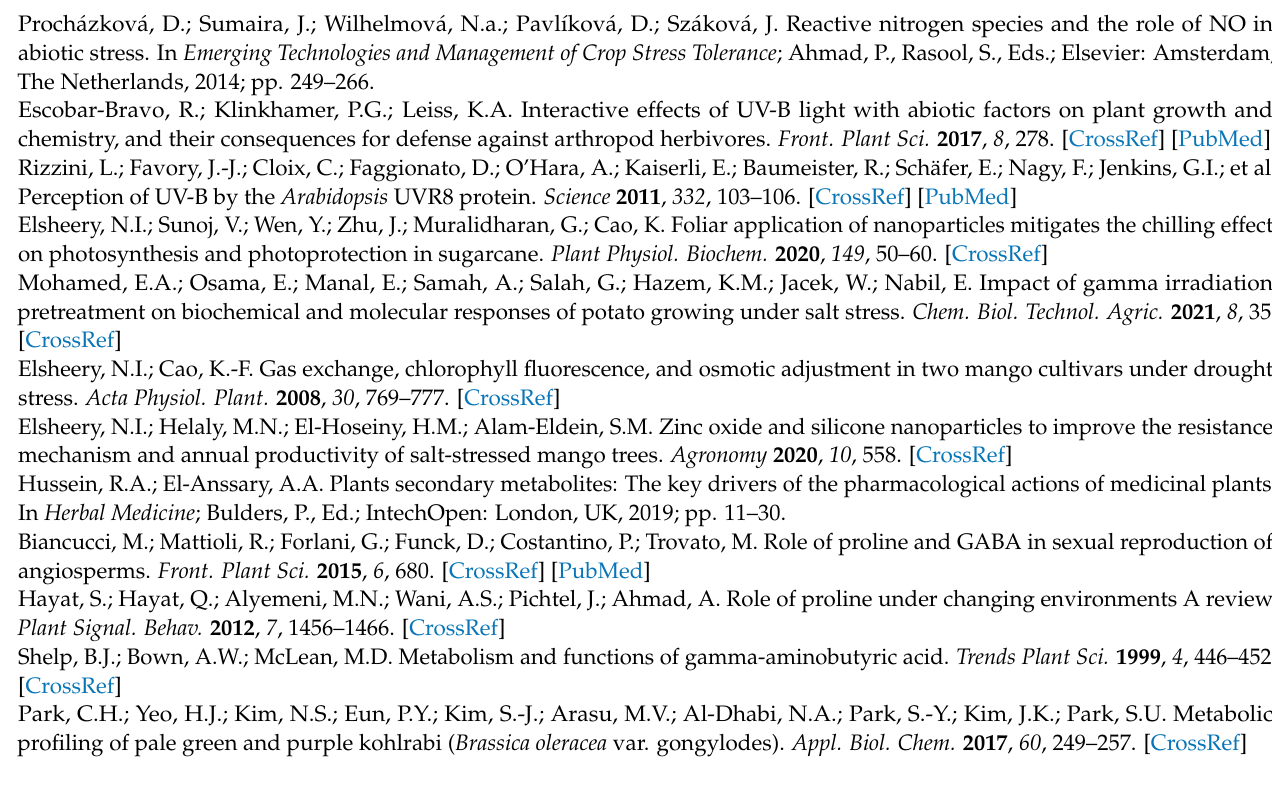
Figure S3. GC-TOFMS chromatogram of hydrophilic compounds in UVB-treated purple kohlrabi sprouts. Peak: 1, Pyruvic acid; 2, Lactic Acid; 3, Alanine; 4, Oxalic acid; 5, Glycolic acid; 6, Valine; 7, Urea; 8, Serine-1; 9, Ethanolamine; 10, Phosphoric acid; 11, Glycerol; 12, Leucine; 13, Isoleucine; 14, Proline; 15, Glycine; 16, Succinic Acid; 17, Glyceric Acid; 18, Fumaric Acid; 19, Serine-2; 20, Threonine; 21, β -Alanine; 22, Malic acid; 23, Aspartic Acid; 24, Methionine; 25, Pyroglutamic Acid; 26, 4-Aminobutyric Acid; 27, Threonic acid; 28, Cysteine; 29, Glutamic Acid; 30, Phenylalanine; 31, Xylose-1; 32, Xylose-2; 33, Arabinose; 34, Asparagine; 35, Xylitol; 36, Ribitol (internal standard) 37, Putrescine; 38, Glutamine; 39, Shikimic acid; 40, Citric acid; 41, Quinic acid; 42, Fructose-1; 43, Fructose-2; 44, Mannose; 45, Glucose-1; 46, Glucose-2; 47, Mannitol; 48, Lysine; 49,Tyrosine; 50, Inositol; 51, Ferulic acid; 52, Tryptophan; 53, Sinapinic acid; 54, Fructose-6-phosphate; 55, Glucose-6- phosphate-1; 56, Glucose-6-phosphate-2; 57, Sucrose; Figure S4. Correlation matrix of anthocyanins, ABTS values, and total phenolics (TPC) in UVB-irradiated purple kohlrabi sprouts. Control, purple kohlrabi sprouts grown without UVB irradiation for 0 h, 6 h, 12 h, 24 h, and 48 h; test, purple kohlrabi sprouts irradiated with UVB for 6 h, 12 h, 24 h, and 48 h; Table S1. Hydrophilic compounds quantified in UVB-treated purple kohlrabi sprouts corresponding to Figure